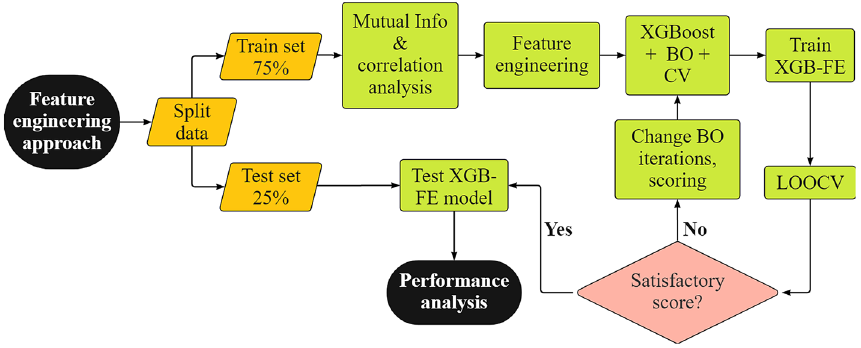
Figure 3. Flowchart for XGB-FE model